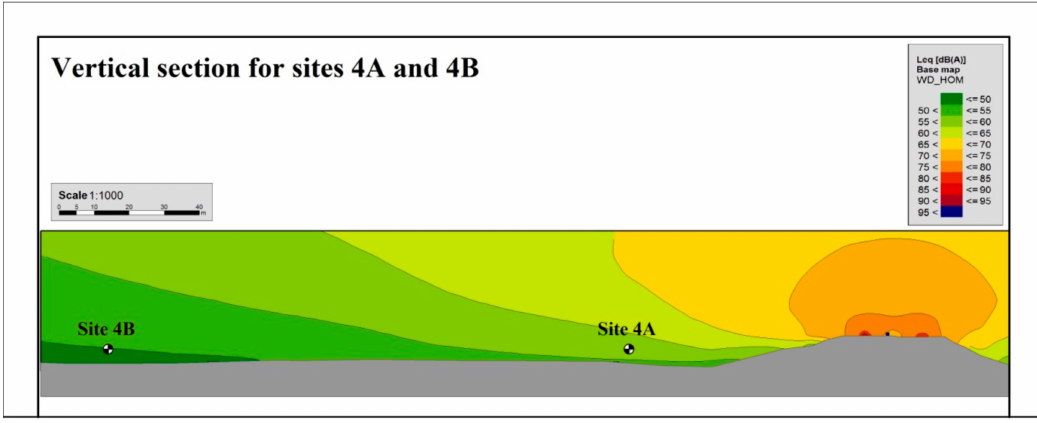
Figure 11. Terrain vertical section corresponding to sites 4A and 4B. Soil characteristics: uncultivated field, site 4A in depressed position, site 4B close to a bush. Equivalent level intervals are displayed with di ff erent colors. Levels calculated according to the Basic Noise Map WD_HOM.